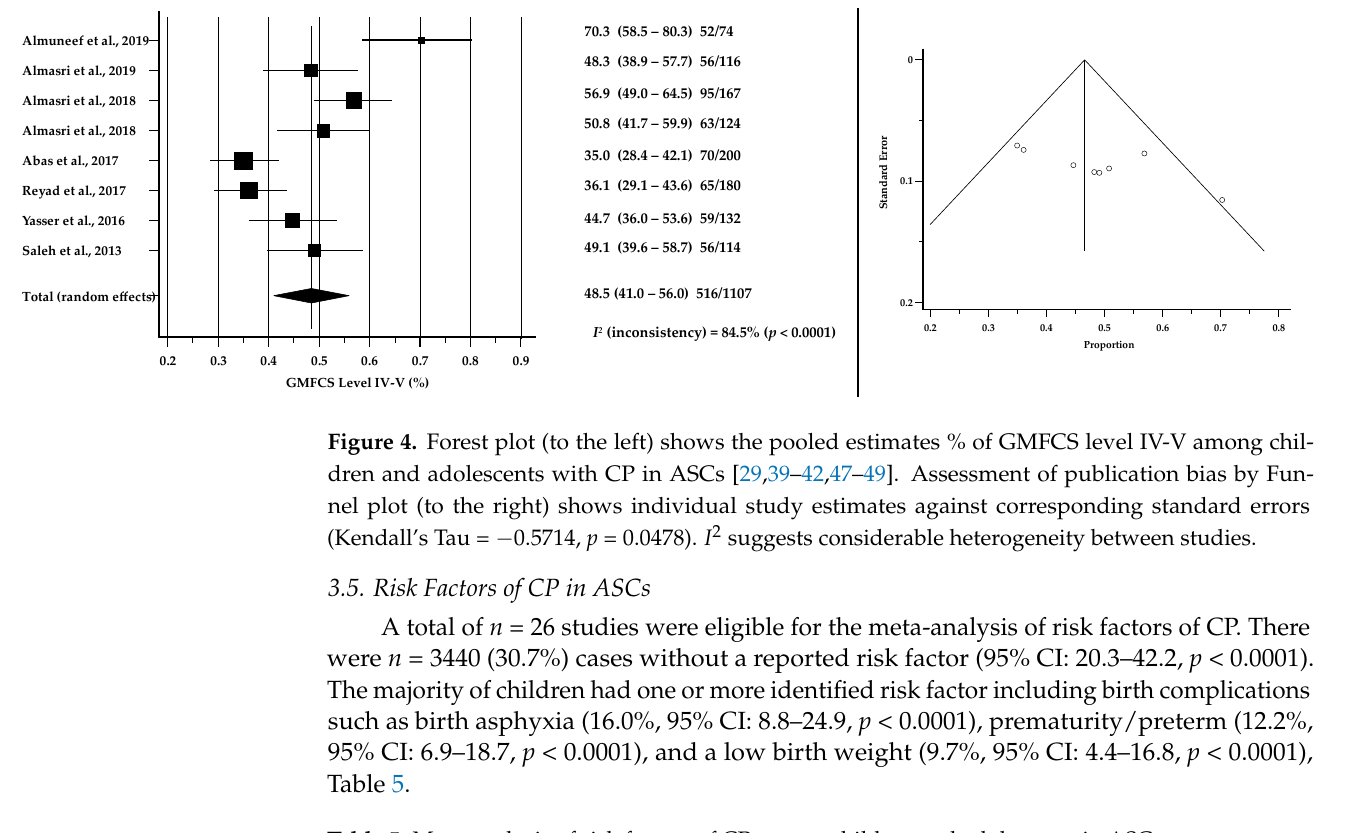
Table 5. Meta-analysis of risk factors of CP among children and adolescents in